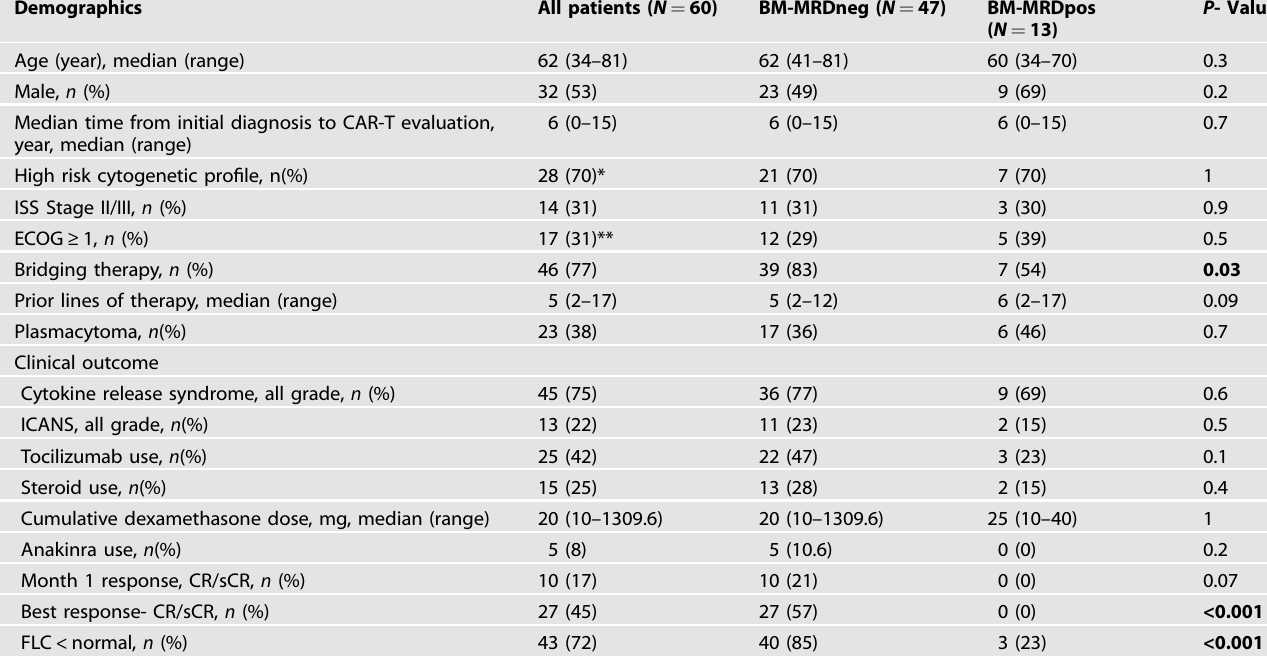
Table 1. Patient demographics and clinical outcomes.